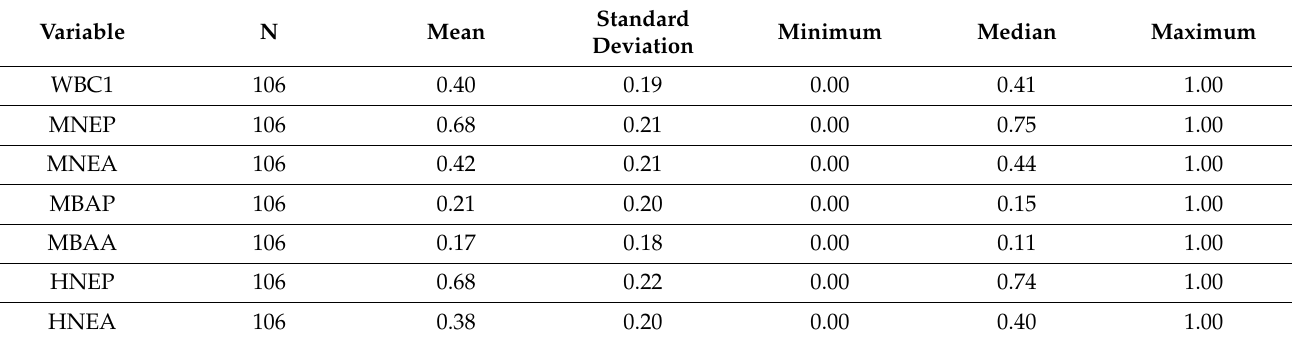
Table 7. Predictors for the appendicitis dataset.